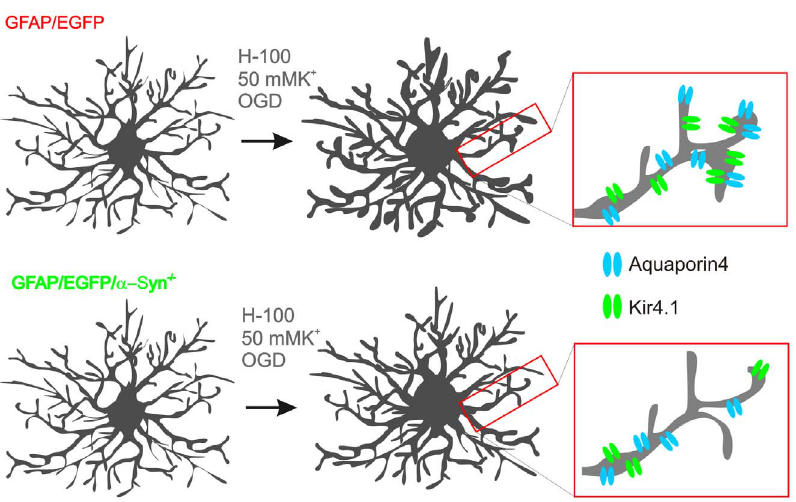
Figure 10. The contribution of processes and cell soma to total astrocyte swelling is altered in astrocytes lacking a -syntrophin. A scheme depicting differences in swelling of astrocytic processes and cell soma in response to severe hypoosmotic stress, 50 mM K + and OGD (oxygen-glucose deprivation), highlighting smaller swelling of astrocytic processes in GFAP/EGFP/ a -Syn 2 / 2 mice compared to those in GFAP/EGFP mice due to altered distribution of aquaporin4 and Kir4.1